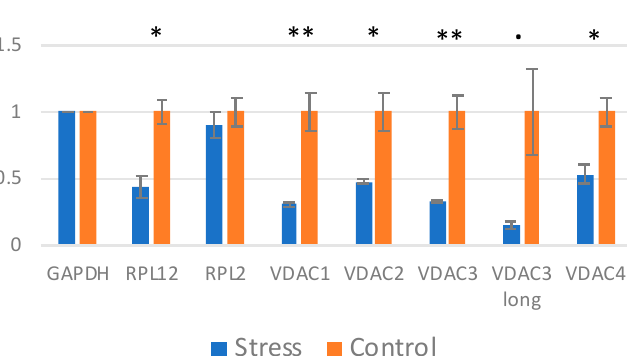
Figure 3. VDAC response to stress. Stress conditions, performed on 8-day-old cell cultures, were 3 h at 37 °C or 4 °C for heat ( A ) and cold stress ( B ), respectively, or 24 h at 23 °C for salinity (150 mM NaCl) ( C ) and oxidative (20 mM H 2 O 2 ) ( D ) stresses and for phosphate depletion ( E ). Total RNAs were extracted and used for RT-qPCR. Normalization was done on RPL12 mRNA ( A – D ), except for phosphate depletion ( E ). In that case, RPL12 messenger was found downregulated and normalization was done on GAPDH. Error bars, SEM. Student’s test p -value: · between 5% and 10%, * between 1% and 5%, ** below 1%.